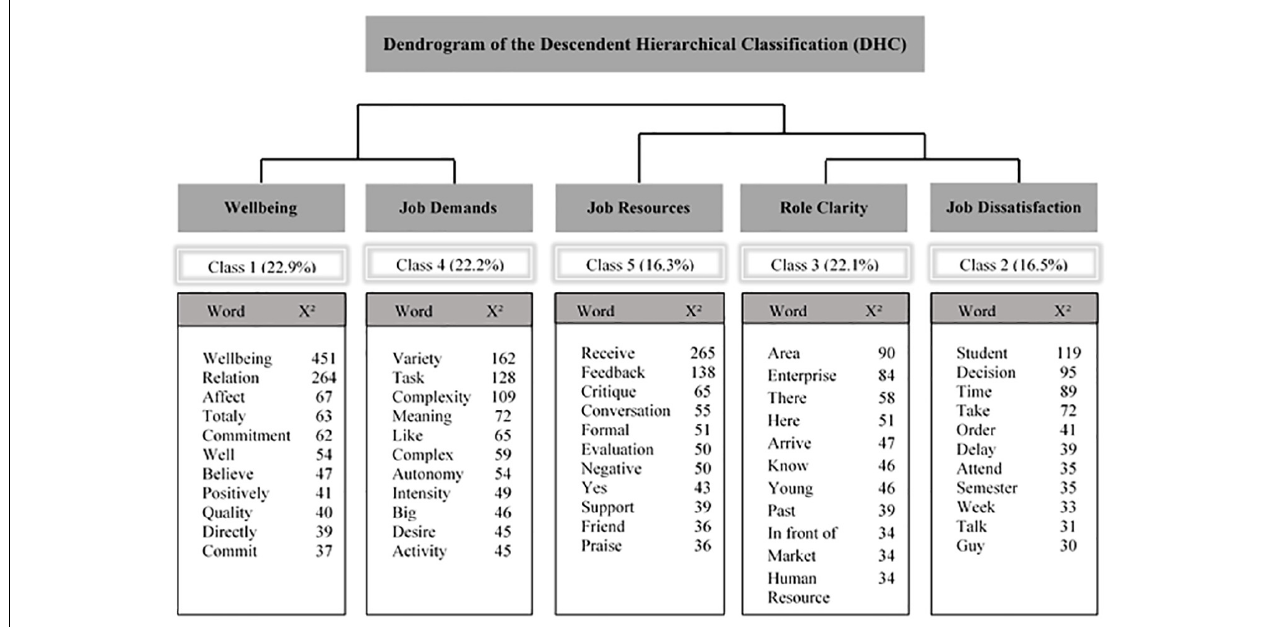
FIGURE 1 | Dendrogram of the Descendent Hierarchical Classification